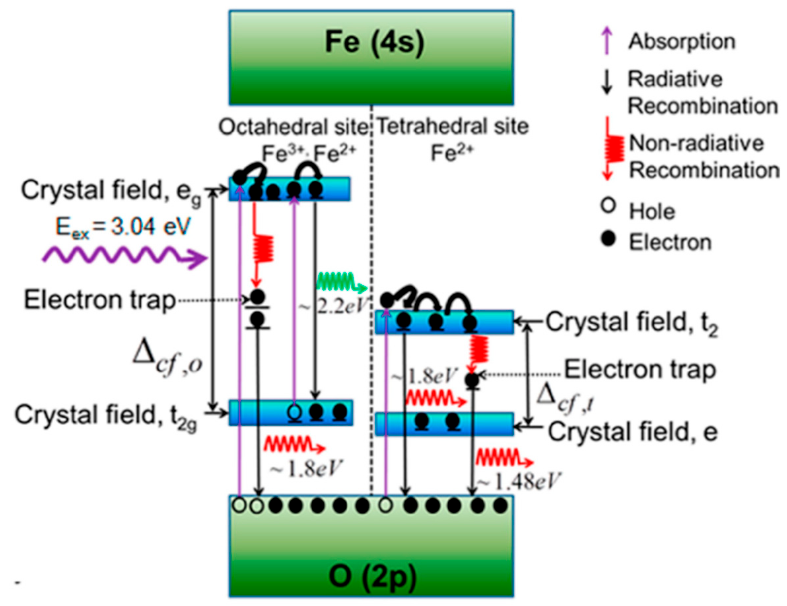
Figure 13. Schematic of the energy bands of the magnetite NPs system [185]. Reprinted (adapted) with permission from